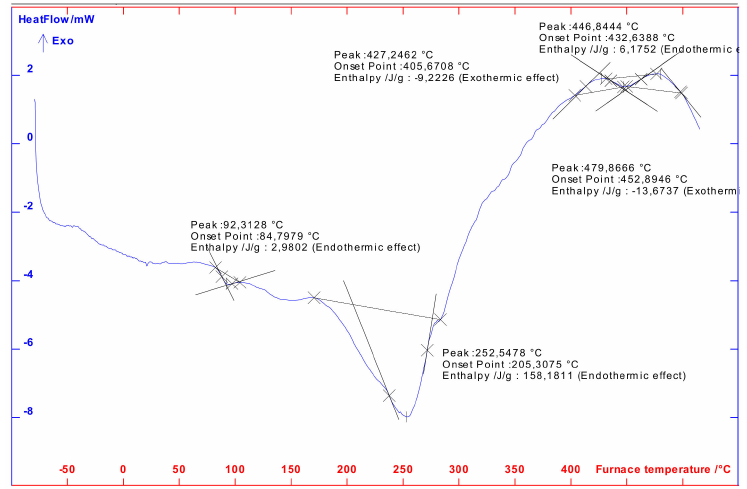
Figure 4. TGA thermogram of P (AA / Kry23-DM) superabsorbent polymer (SAP).